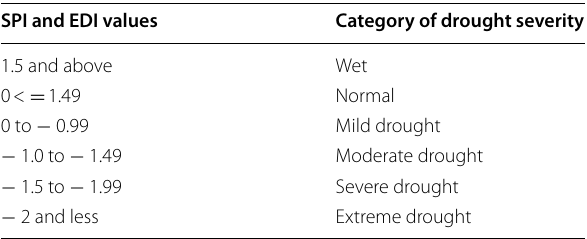
Table 3 SPI and EDI based category of drought severity ( Source: McKee et al.